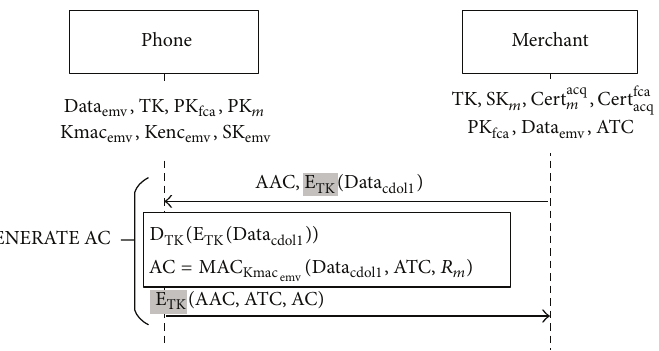
Figure 7: Rejection of transaction in EMV standard (modifications are